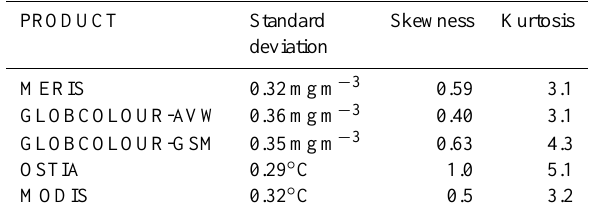
Table 1. Values of the standard deviation, skewness and kurtosis for the different products.